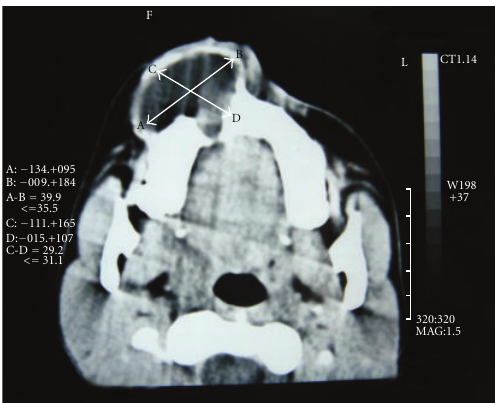
Figure 5: CT showing large expansile lytic lesion arising from the right maxilla extending into the right maxillary antrum and anterior portion of the right nasal cavity.